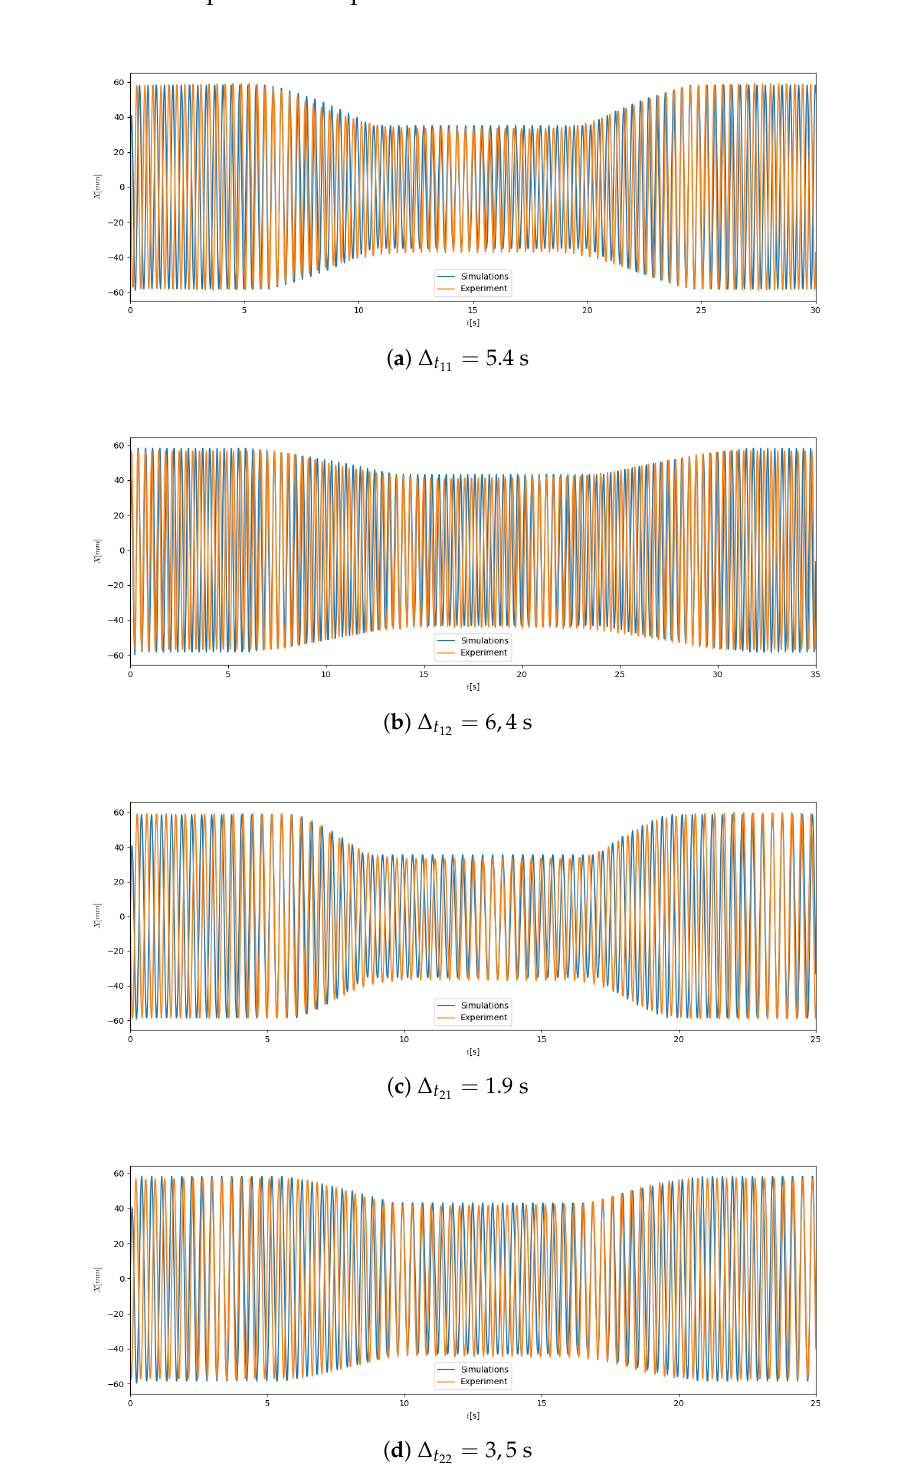
Figure 13. Verification of experimental and numerical data for various operational parameters: ( a ) 10% mass of grains, 4.5 s activation time; ( b ) 5% mass of grains, 4.5 s activation time; ( c ) 10% of grains, 1.5 s activation time; ( d ) 5% mass of grains, 1.5 s activation